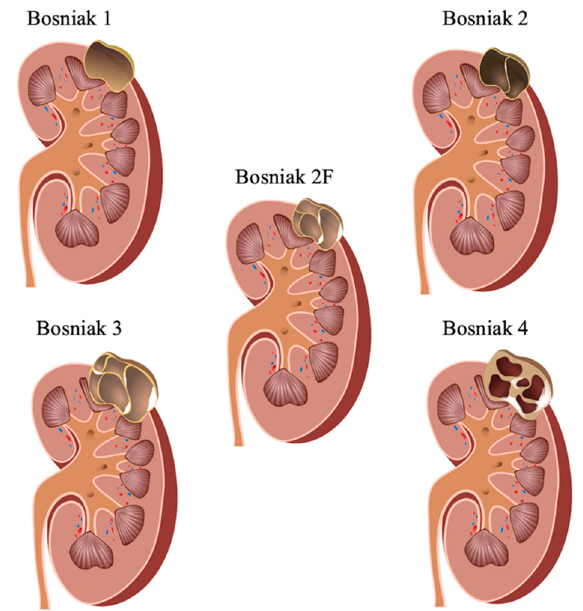
Figure 1. Illustration of Bosniak classification and the corresponding morphological features. Bosniak 1—hairpin-thin cystic walls, well-defined; Bosniak 2—septa < 1 mm, fine septal calcifications, no contrast-enhancement / discrete septal contrast-enhancement; Bosniak 2F—multiply septated, thickened cystic walls, thin / thick calcifications, discrete mural / septal contrast-enhancement; Bosniak 3—homogeneous / irregular thickening of septa / wall, irregular calcifications, increasing septal contrast-enhancement; Bosniak 4—features of Bosniak 3 + solid components, irregular solid contrast-enhancing components.